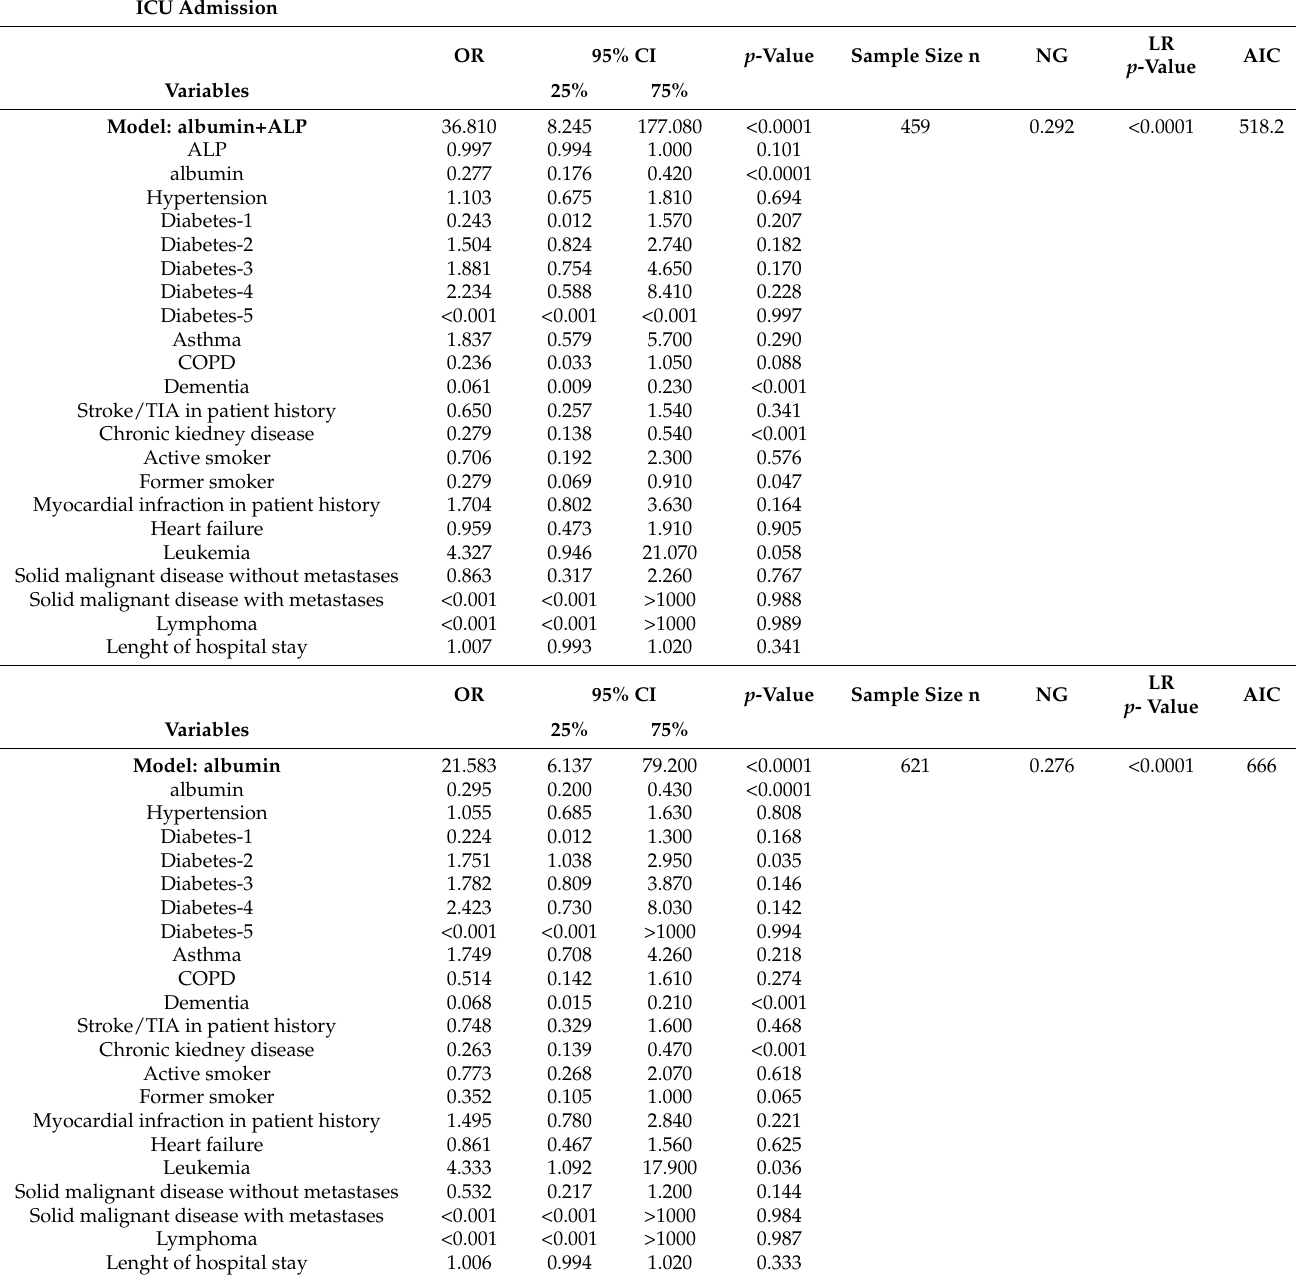
Table 5. The best models to predict ICU admission in COVID-19 tested on larger groups of